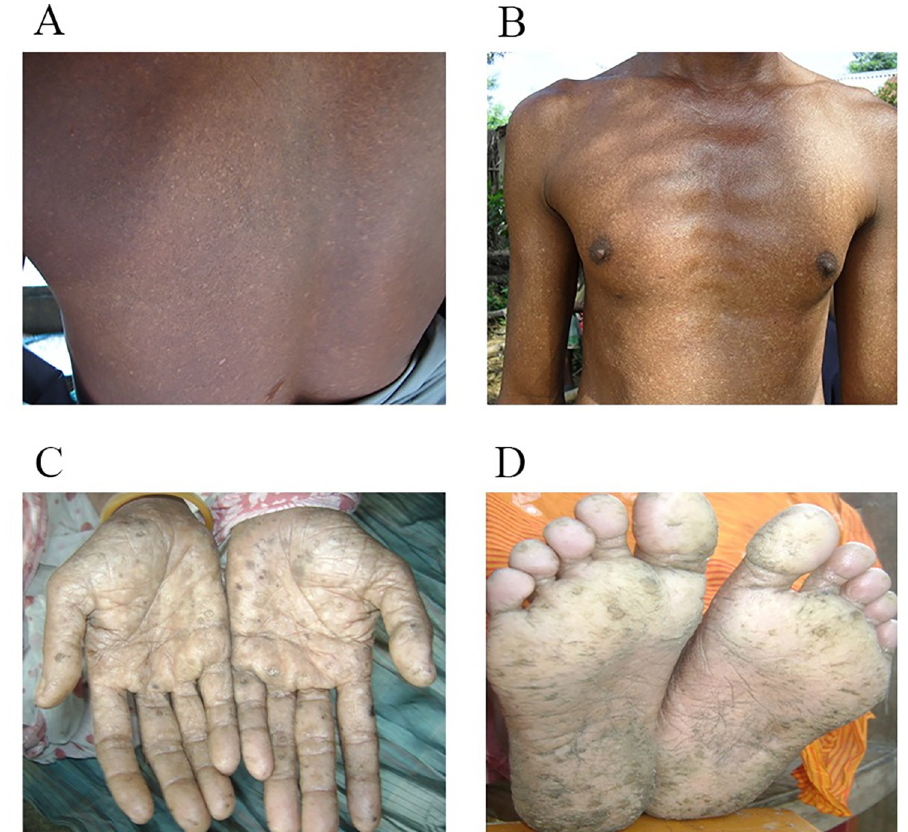
Fig 1. Representative photographs of arsenic-induced skin lesions. A. Leucomelanosis on the back, B. Diffuse pigmentation on the chest, C. Severe hyperkeratosis (large nodular keratosis) on the palms, and D. Severe hyperkeratosis on the